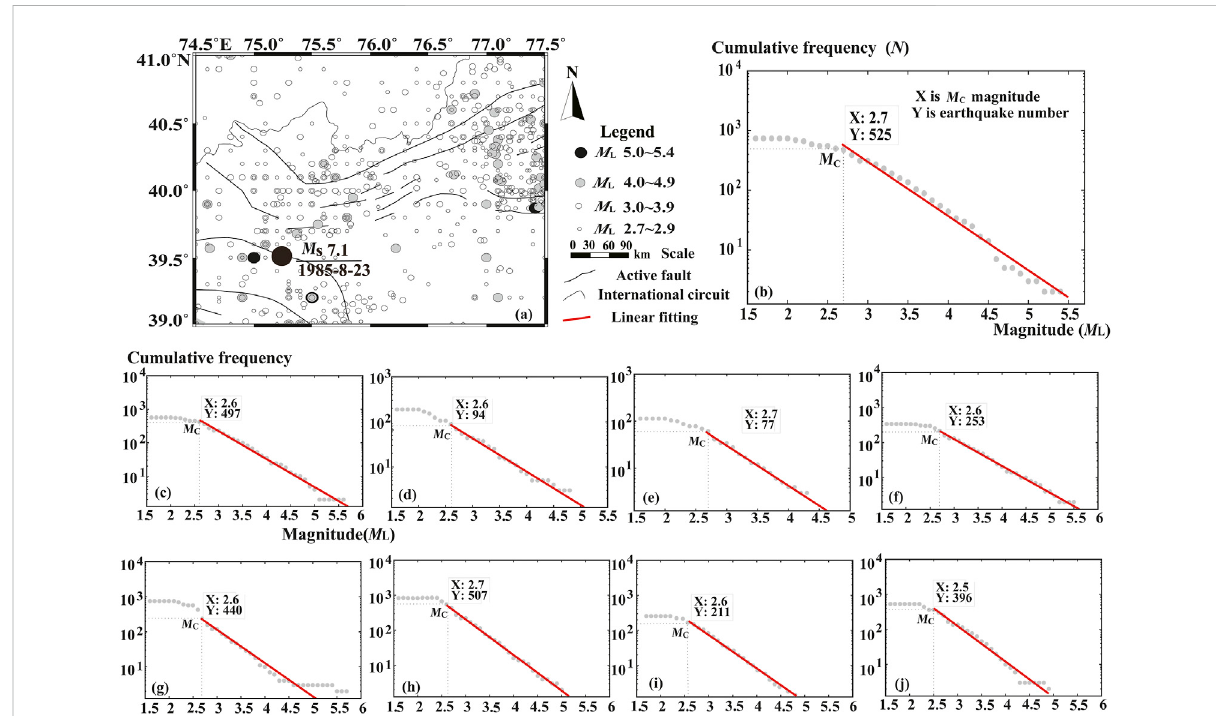
FIGURE 2 Spatial distribution of M s 7.1 Wuxia earthquake epicenters, The gray circles represent earthquakes of magnitude 2.7 to 5.4 (A) .The G-R relationship of 9 earthquake cases above M s 7 in the study area, the gray dot represents the cumulative number of earthquakes, and the red line representsthelinear fi t (B – J) . (B) 1985 M s7.1Wuxiaearthquake; (C) 1988 M s7.6Lancang – Gengmaearthquake; (D) 1990 M s7.0Gongheearthquake; (E) 1990 M s 7.2 Jeminay earthquake; (F) 1995 M s 7.3 Myanmar – China earthquake; (G) 1996 M s 7.0 Lijiang earthquake; (H) 2008 M s 8.0 Wenchuan earthquake; (I) 2013 M s 7.0 Lushan earthquake; (J) 2017 M s 7.0 Jiuzhaigou